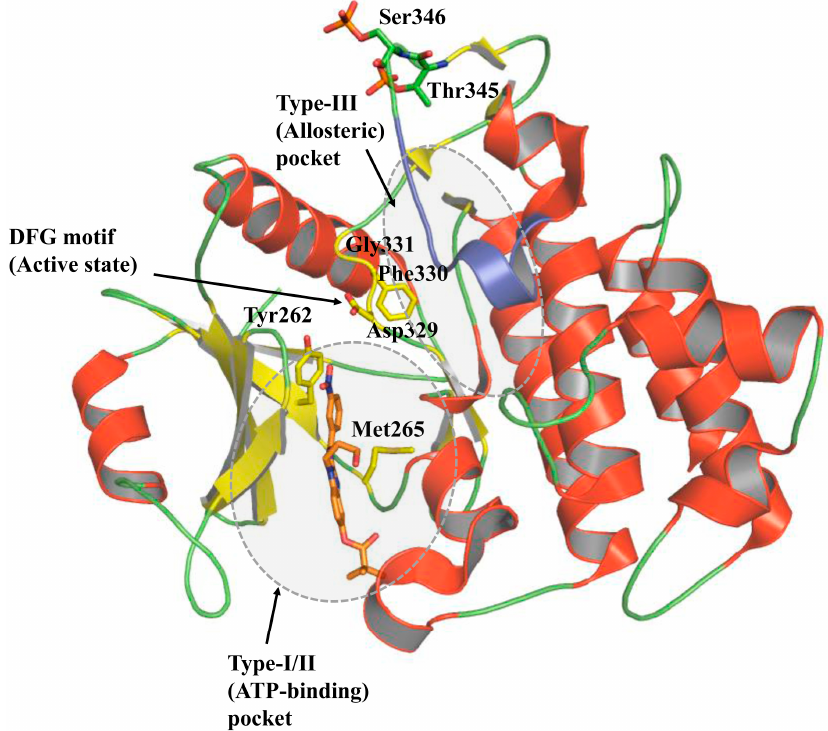
Figure 6. Illustration of Type-I, Type-II, and Type-III binding pockets of IRAK4 kinase domain. Type-I and type-II binding pockets are determined by the positions of Phe and Asp residues from the Asp-Phe-Gly (DFG) motif. Type-I binding site is formed in DFG-in condition, where the side chain of Phe faces towards the catalytic center, while the side chain of Asp faces in the opposite direction. Type-II binding site is formed when Phe and Asp side chains rotate 180°. Type-III binding site is the allosteric site, where IRAK1 is phosphorylated by IRAK4.